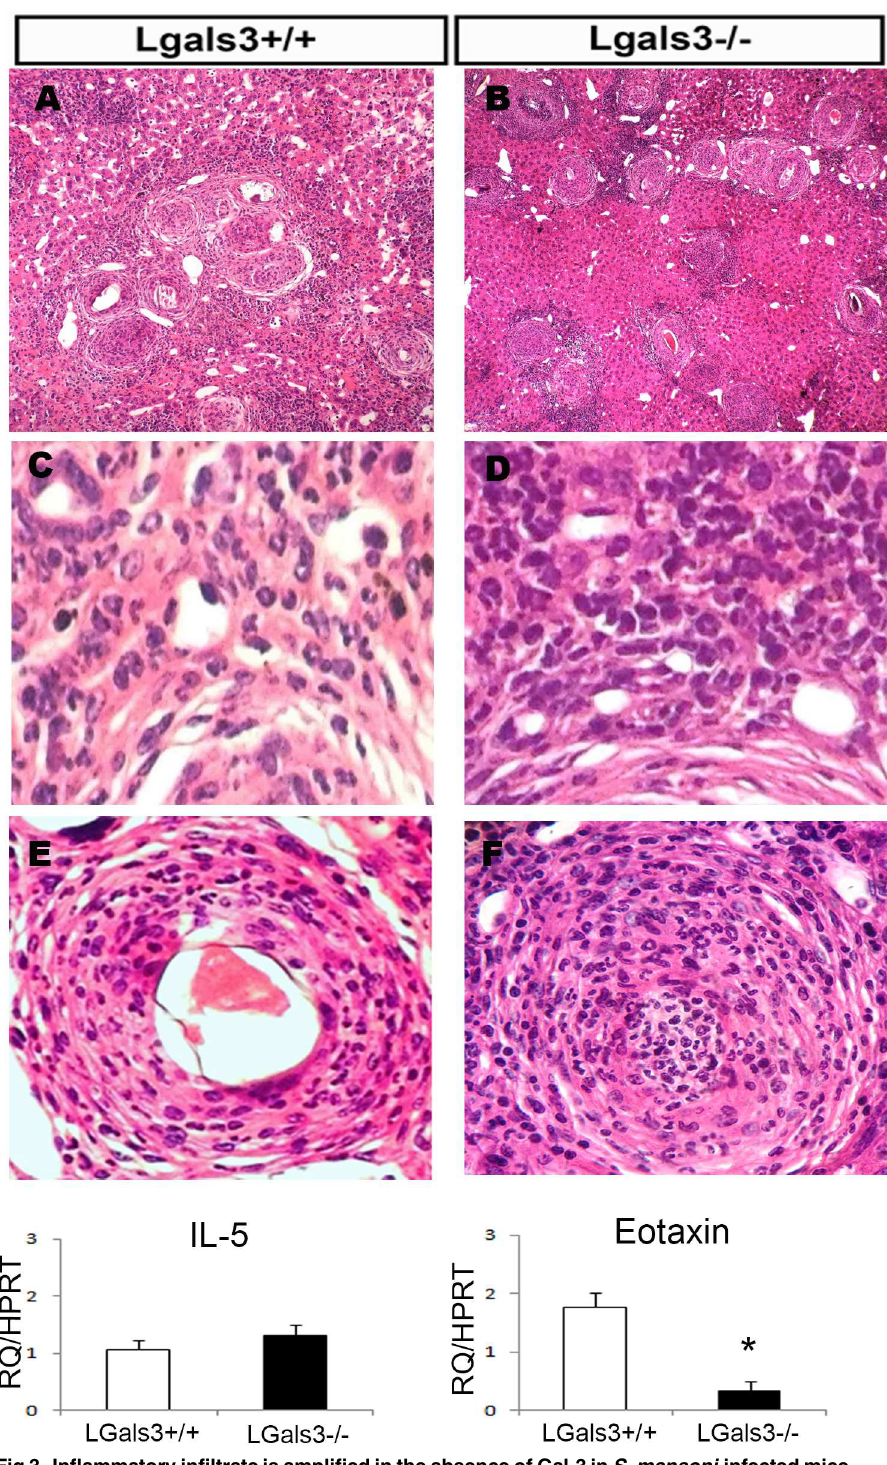
Fig 3. Inflammatory infiltrate is amplified in the absence of Gal-3 in S . mansoni -infected mice. Hematoxylin & eosin stainingshow granulomas of Lgals-3+/+mice (A) and Lgals-3-/-mice (B), where abundant myeloid cells were detected aroundthe eggs. Myeloidcells were preferentially localizedaroundthe eggs in Lgals-3+/+ mice (C,E). In contrast, myeloidcells were abundantaroundthe eggs and inside the hepaticparenchyma in Lgals-3-/-mice (D,F), suggestinga local amplification insteadof central